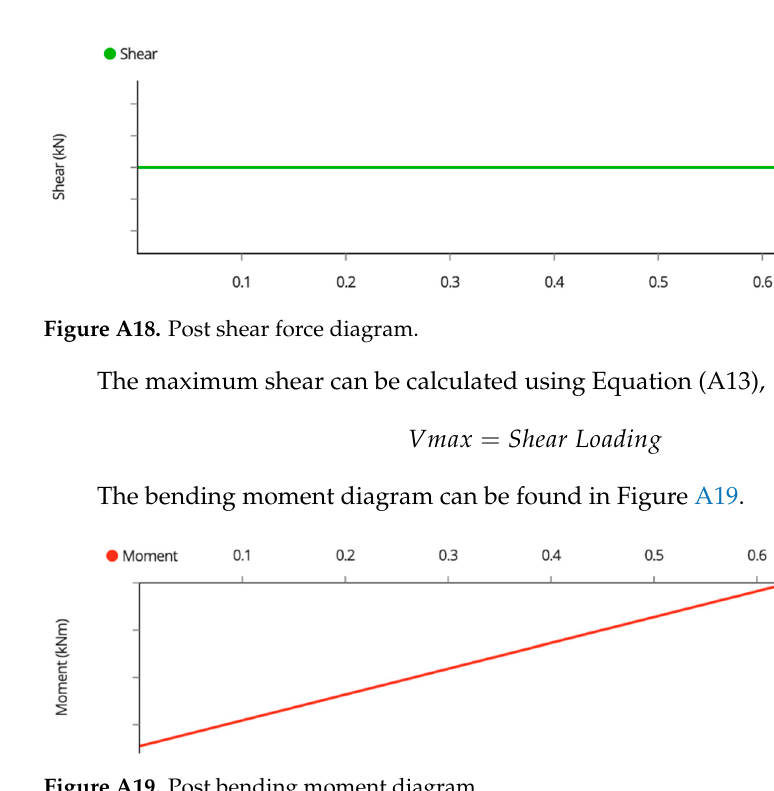
Figure A19. Post bending moment diagram. The maximum bending moment can be calculated using Equation (A14).